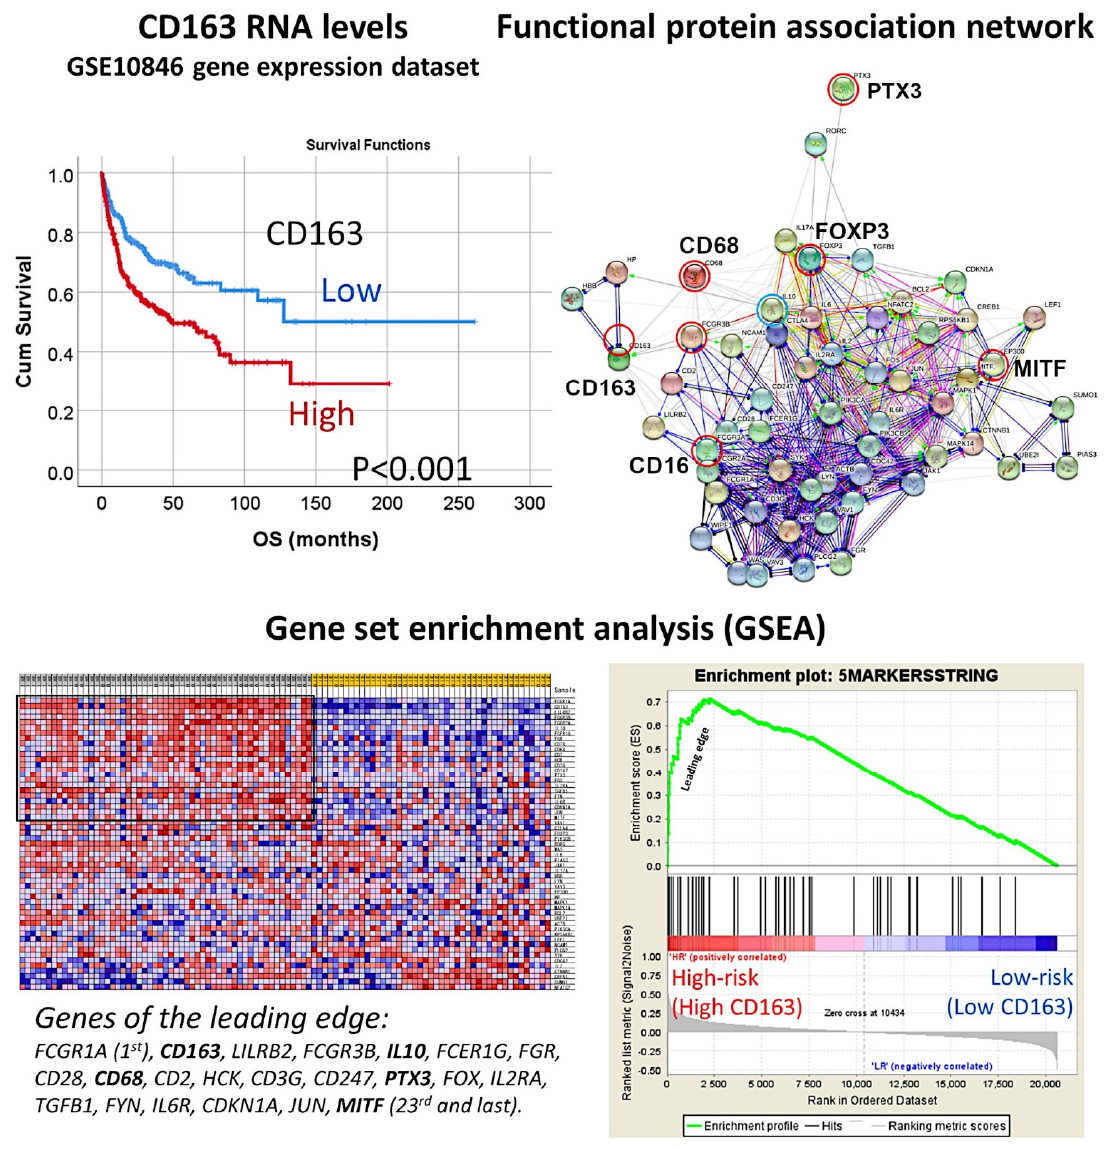
Figure 20. Analysis of macrophages in diffuse large B-cell lymphoma. The overall survival of diffuse large B-cell lymphoma was assessed based on the expression of CD163 , which is an M2-like macrophage marker. High expression was associated with a poor prognosis of the patients. Then, a protein–protein functional network association analysis was performed using the macrophage markers of CD68 (pan-macrophages), CD16 (M1-like macrophages), CD163 (M2-like), PTX3 (M2c-like), and MITF (M2-like), and the regulatory T lymphocytes (Tregs) marker of FOXP3. The network created a macrophage pathway that was subsequently applied to a gene set enrichment analysis (GSEA). The GSEA confirmed the association of the macrophage pathway with the high-risk group, which was characterized by poor overall survival and high CD163-positive macrophages.